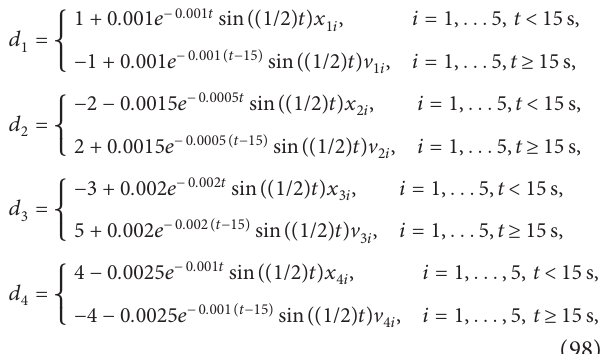
and disturbance estimation 􏽢 d 2